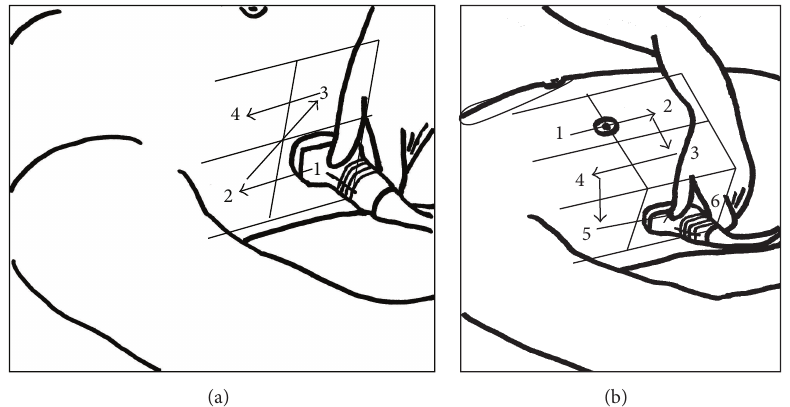
Figure 2: (a)-(b) Standardized training sequence for ultrasound examination of the right hemithorax. Trainees had to examine four views for pleural effusion (a) or six views for pneumothorax (b) by correct positioning of the ultrasound